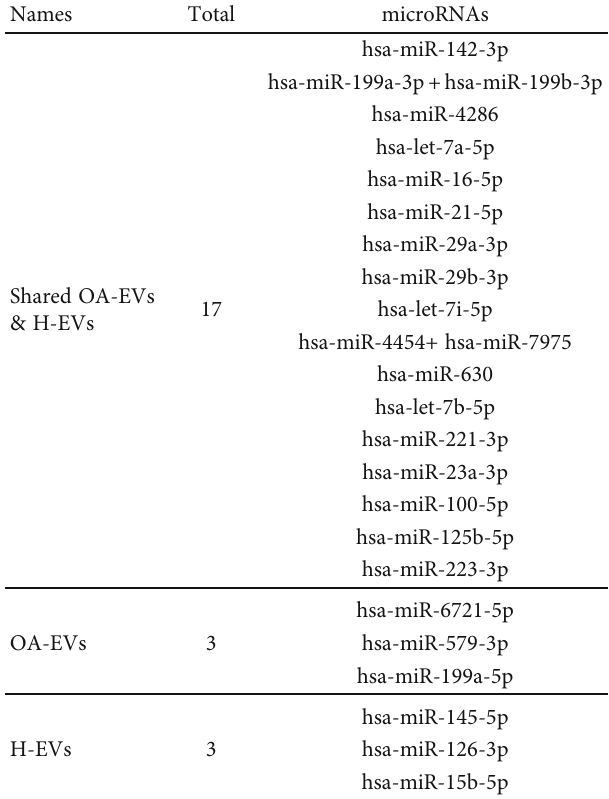
Table 3: microRNAs highly expressed in OA-EVs and control H-